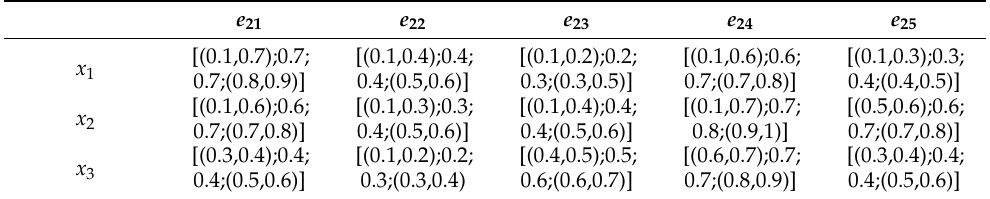
Table A11. The different risk evaluation values subordinated by influencing factors of B 2 at time t 3 .